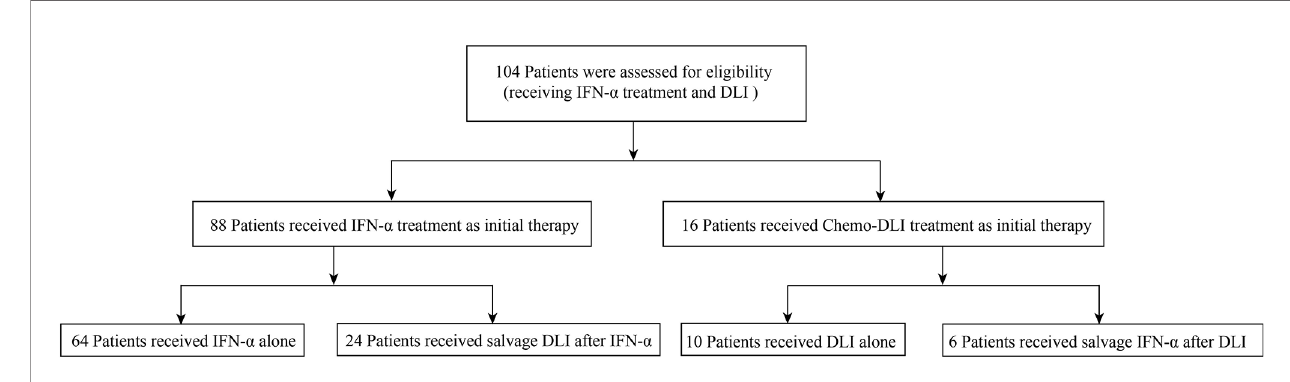
FIGURE 1 | Diagram of patients enrolled.